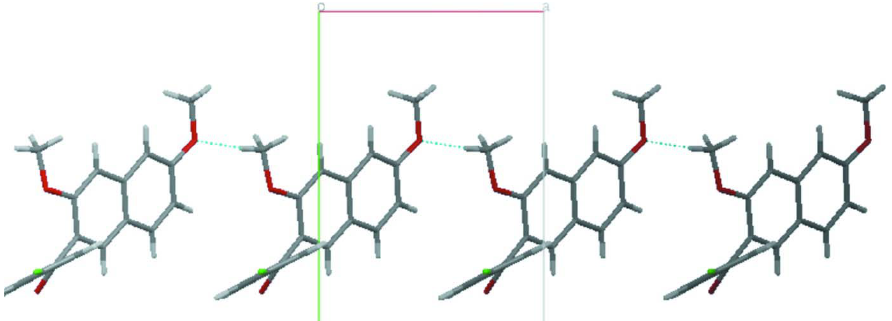
Figure 1 Molecular structure of (I), with the atom-labeling scheme and displacement ellipsoids drawn at the 50% probability level.